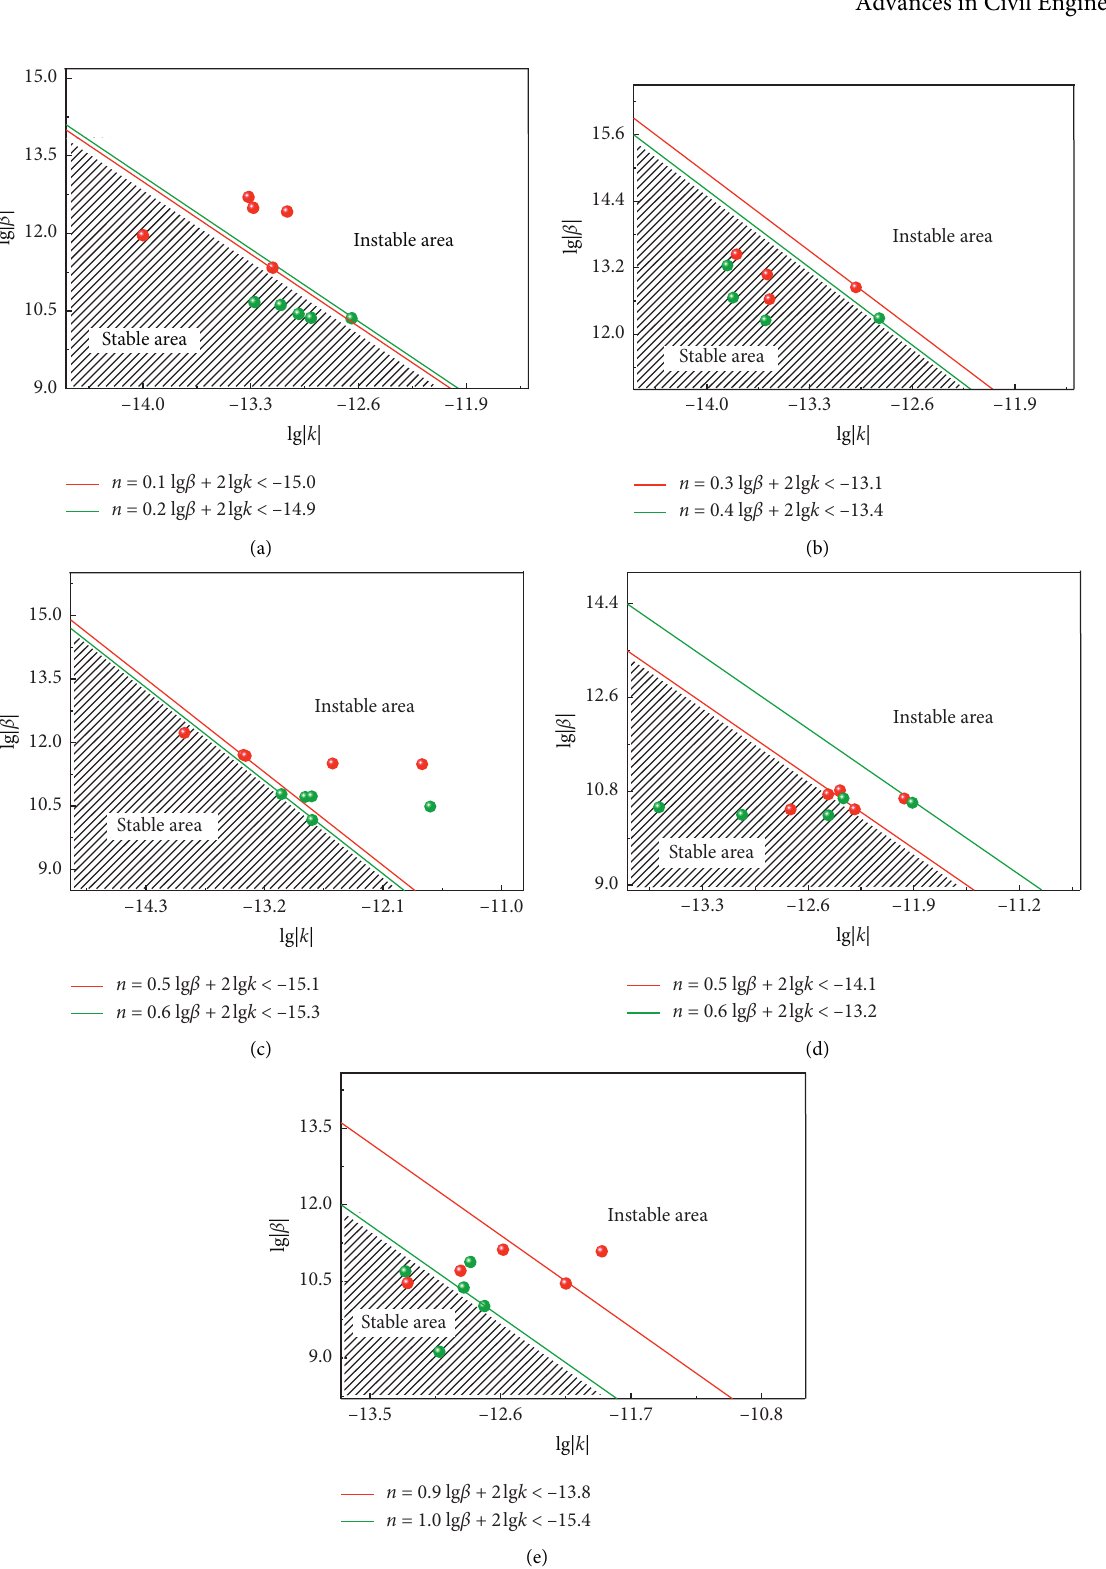
Figure 8: The seepage states of stability of fractured coal. (a) n � 0.1; n � 0.2. (b) n � 0.3; n � 0.4. (c) n � 0.5; n � 0.6. (d) n � 0.7; n � 0.8. (e) n � 0.9; n �